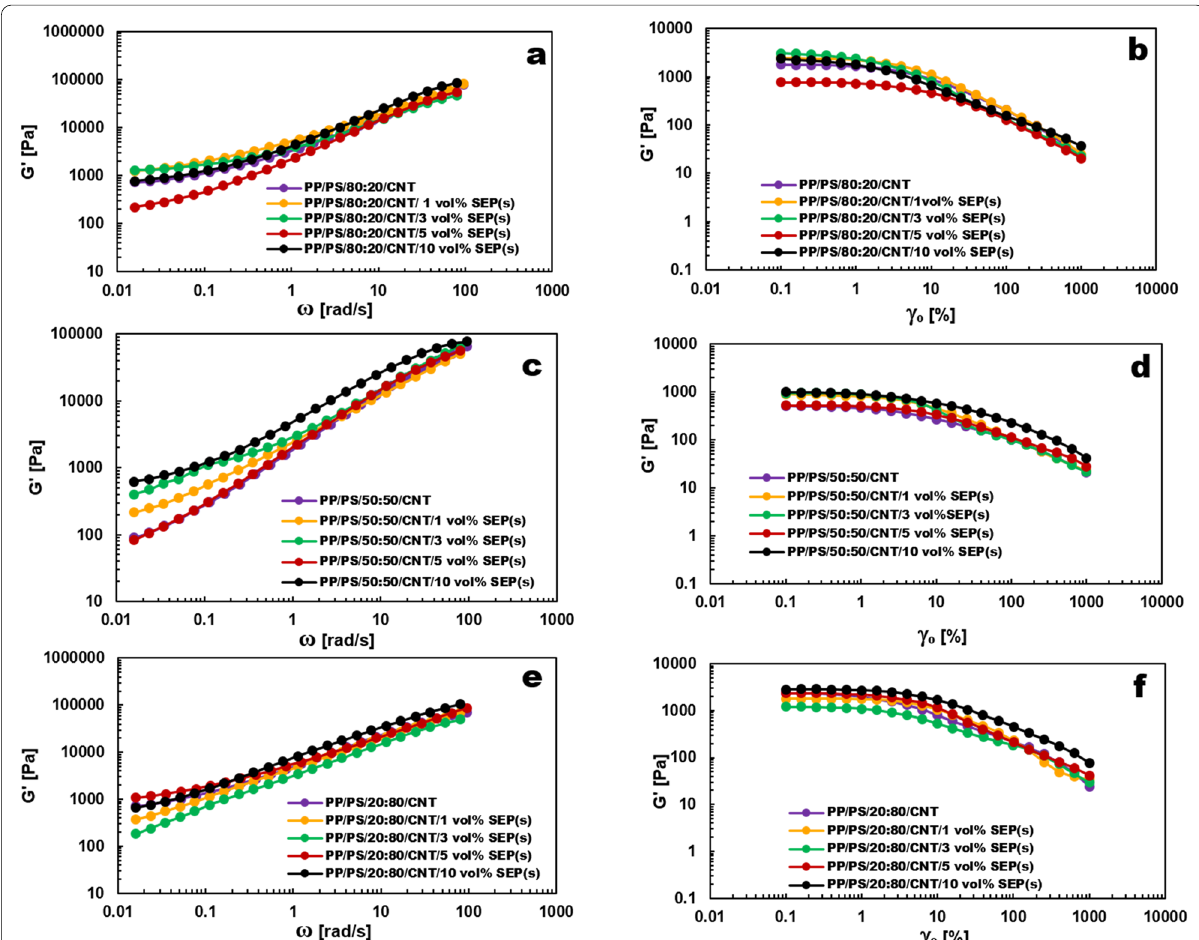
Fig. 6 Frequency and strain sweep of PP/PS/MWCNT/SEP(s) diblock at different concentration a-b ) 80:20, c-d ) 50:50, and e-f ) 20:80 blend